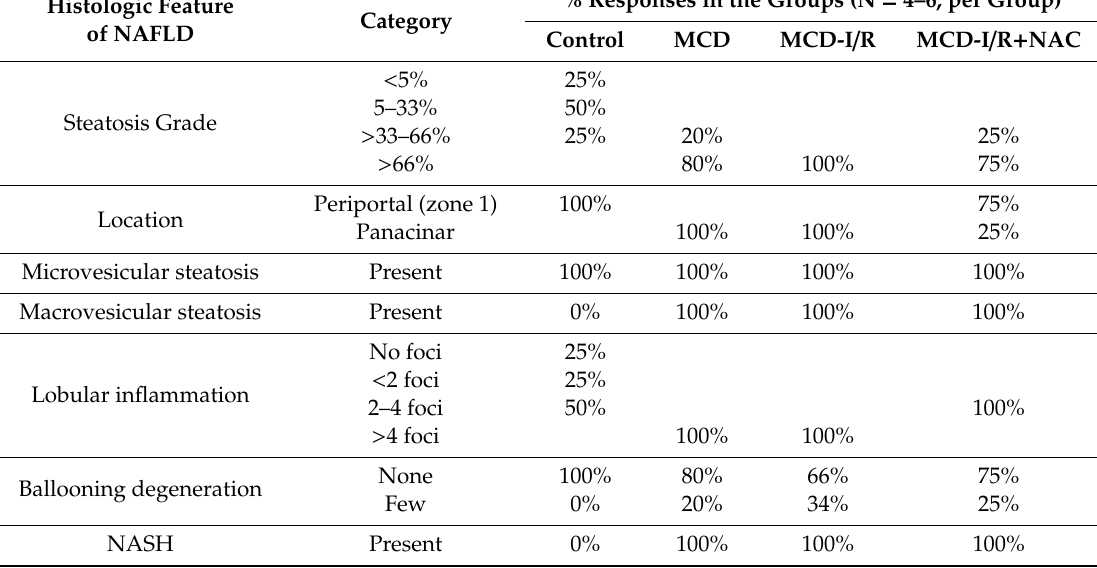
Table 1. Liver histological aspects of normal mice and of animals submitted to I / R in the MCD diet treated or not with N -acetylcysteine (NAC). NAFLD: nonalcoholic fatty liver disease; NASH: nonalcoholic